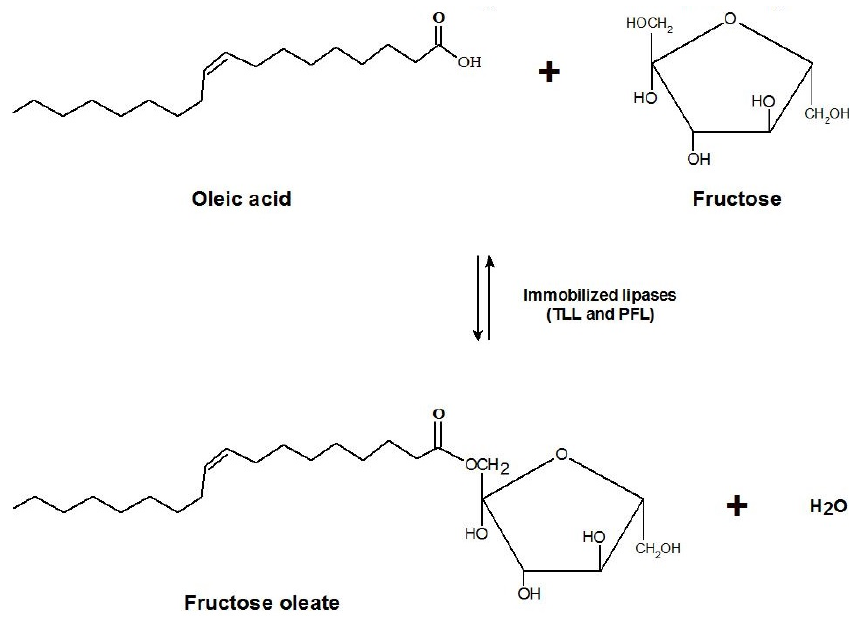
Figure 6. Schematic representation of the enzymatic synthesis of fructose oleate .